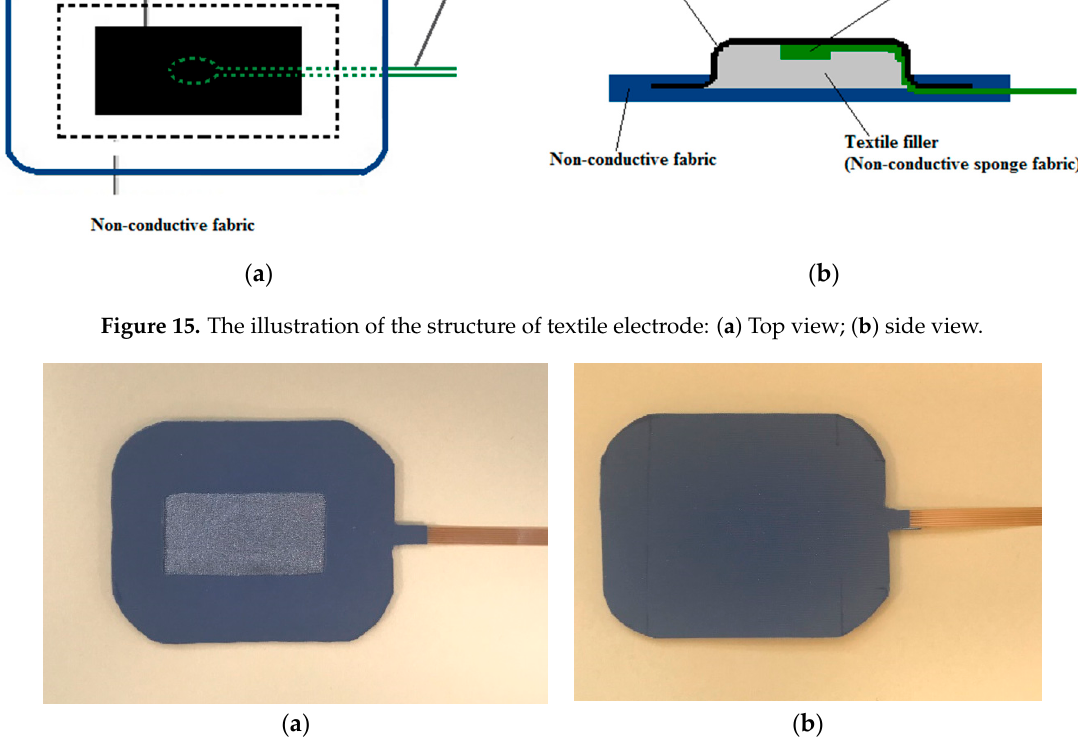
Figure 16. Hybrid textile electrode: ( a ) Top view; ( b ) rear view.